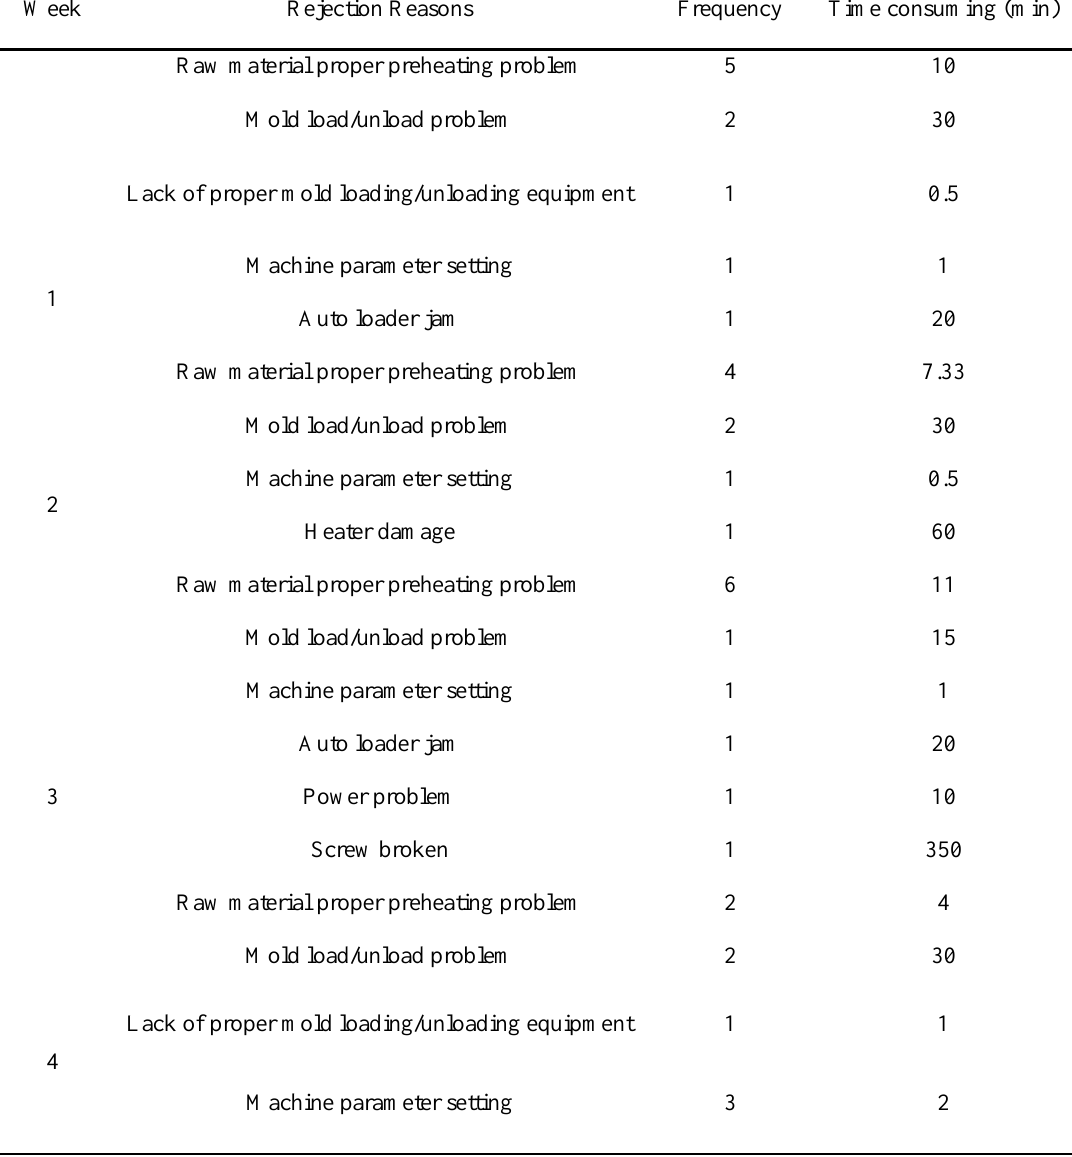
Table 6. Reasons for Rejection of Products for Several Weeks (4